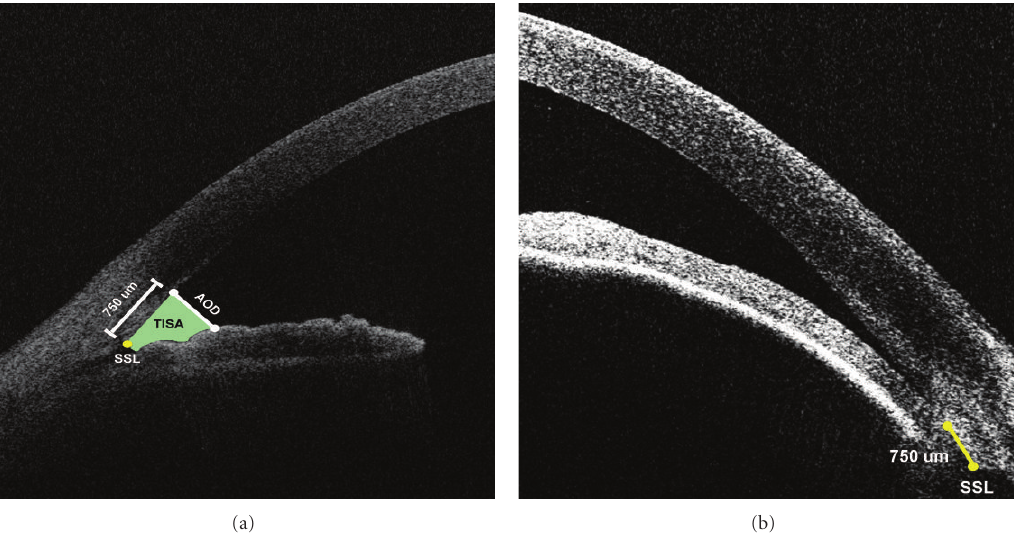
Figure 1: Anterior chamber angle measurements and scleral spur landmark (SSL). Illustrations are angle opening distance (AOD) and trabecular-iris space area (TISA) for an (a) open angle and (b) nonopen angle. AOD is defined as the length of a line drawn perpendicular to the cornea anterior to the SSL and ending on the anterior surface of the iris. TISA is the area bordered centrally by the AOD line, anteriorly by the posterior corneoscleral-aqueous interface, and posteriorly by the anterior surface of the iris. The peripheral border is a line segment starting at the SSL perpendicular to the corneoscleral-aqueous interface and ending on the anterior surface of the iris.